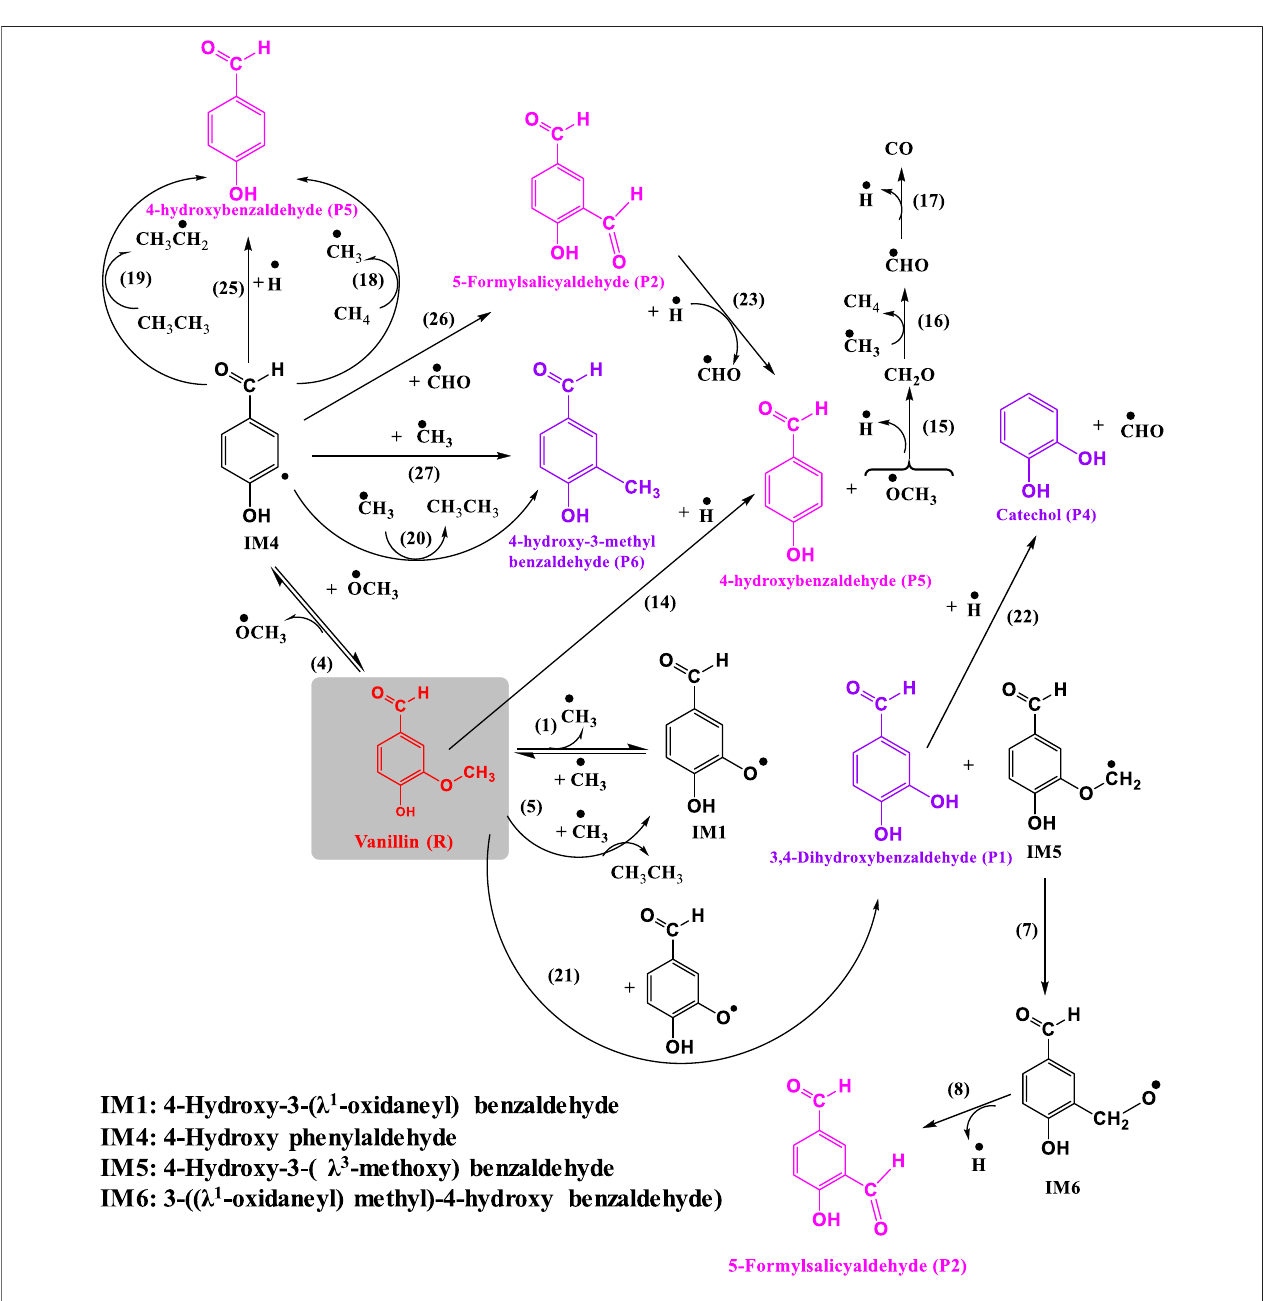
FIGURE 1 | Reaction mechanism of pyrolysis of vanillin to 5-formylsalicyaldehyde and 4-hydroxybenzaldehyde.